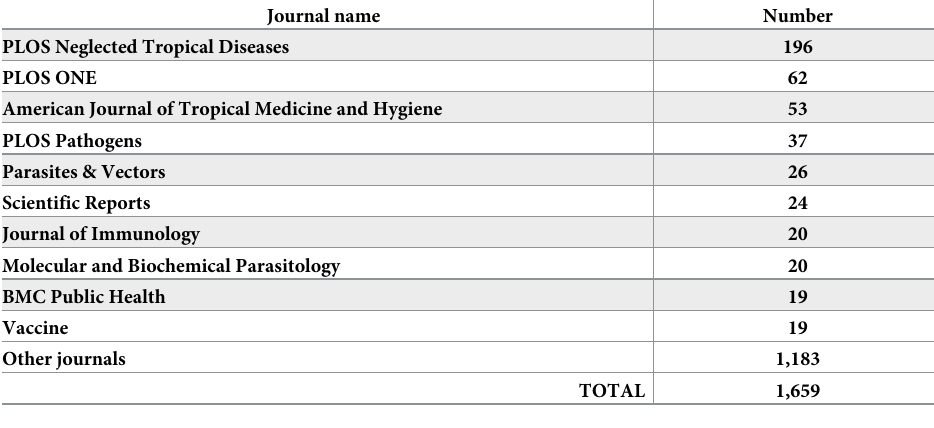
Table 2. Journals where Canadian contributions to NTD research were published between January 1, 2010 and December 31,